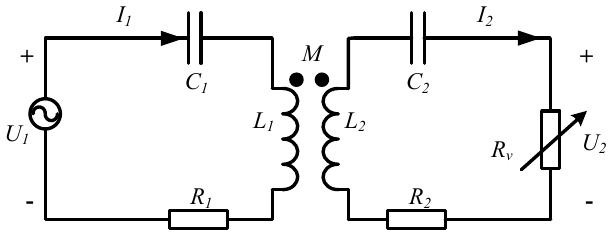
Figure 3. Equivalent circuit of VRB transmitter and receiver.